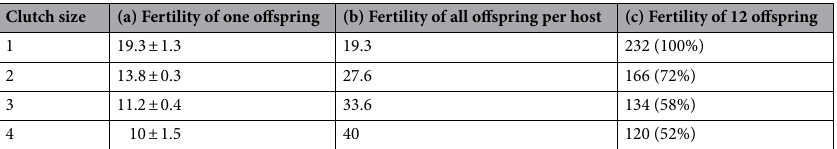
Table 1. The fertility of the gregarious parasitoid A. flavipes among different clutch sizes (mean ± 95% confidence interval). The column "(c)" shows that the fertility of females in the F2 generation can be reduced by almost half, due to the different distributions of 12 offspring into clutch